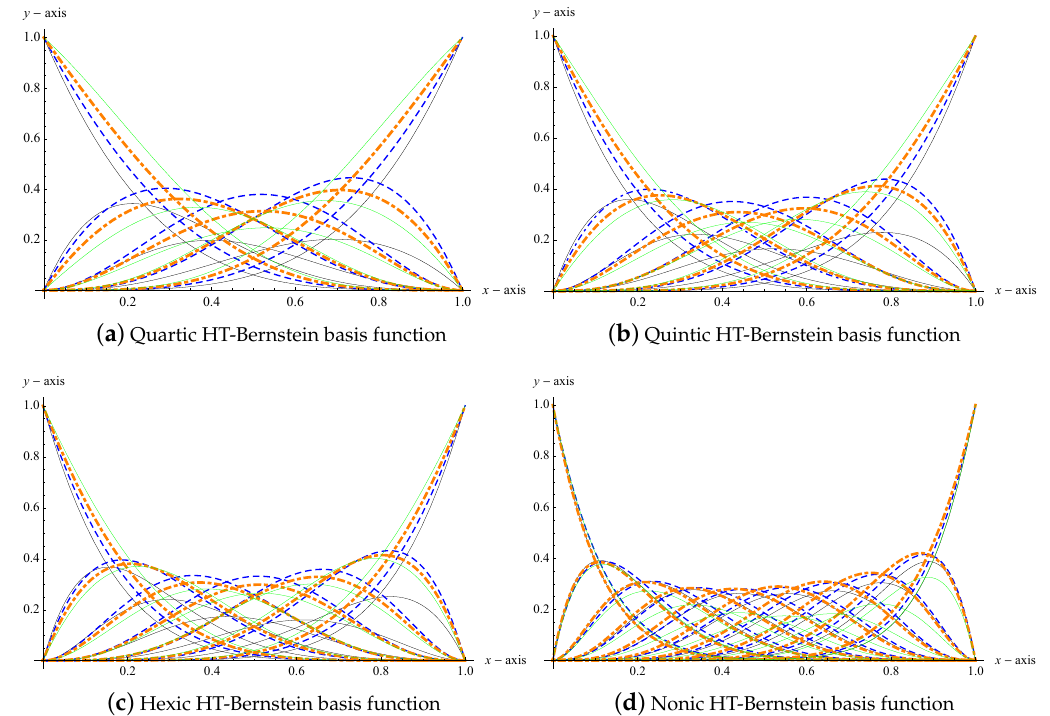
Figure 1. GHT-Bernstein basis functions of various degrees. ( a ) Quartic HT-Bernstein basis function; ( b ) quintic HT-Bernstein basis function; ( c ) hexic HT-Bernstein basis function; ( d ) nonic HT-Bernstein basis